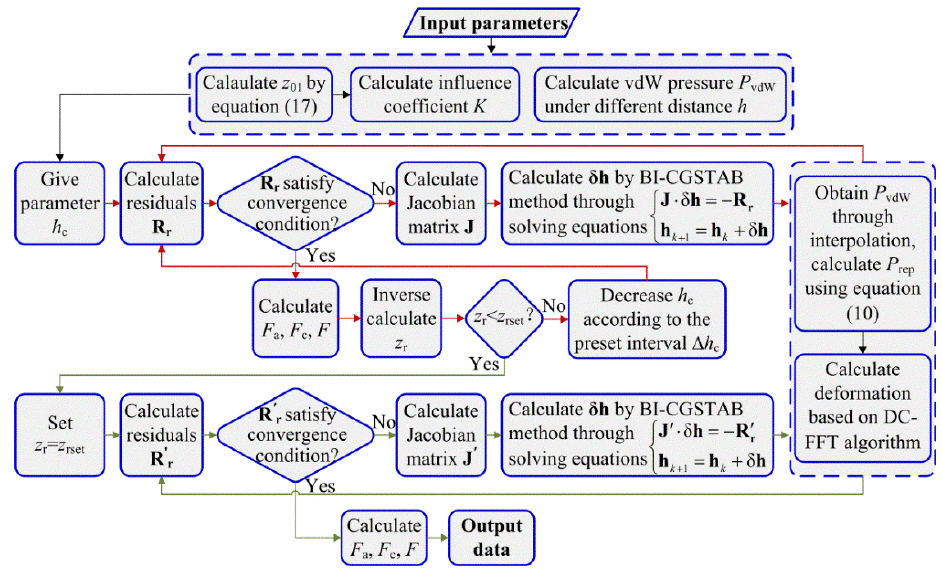
Figure 4. Flowchart for the computational procedure.